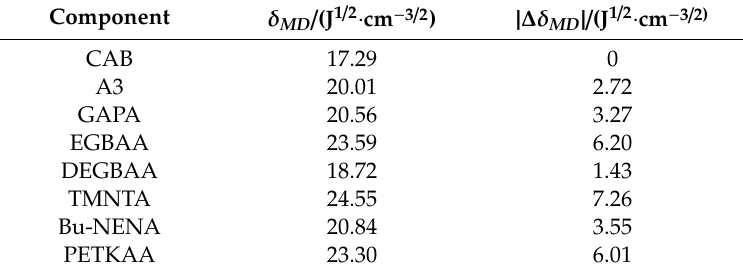
Table 1. Solubility parameters ( δ MD ) of CAB and each plasticizer and the respective di ff erences ( | ∆ δ MD | ) between the solubility parameters of CAB and di ff erent